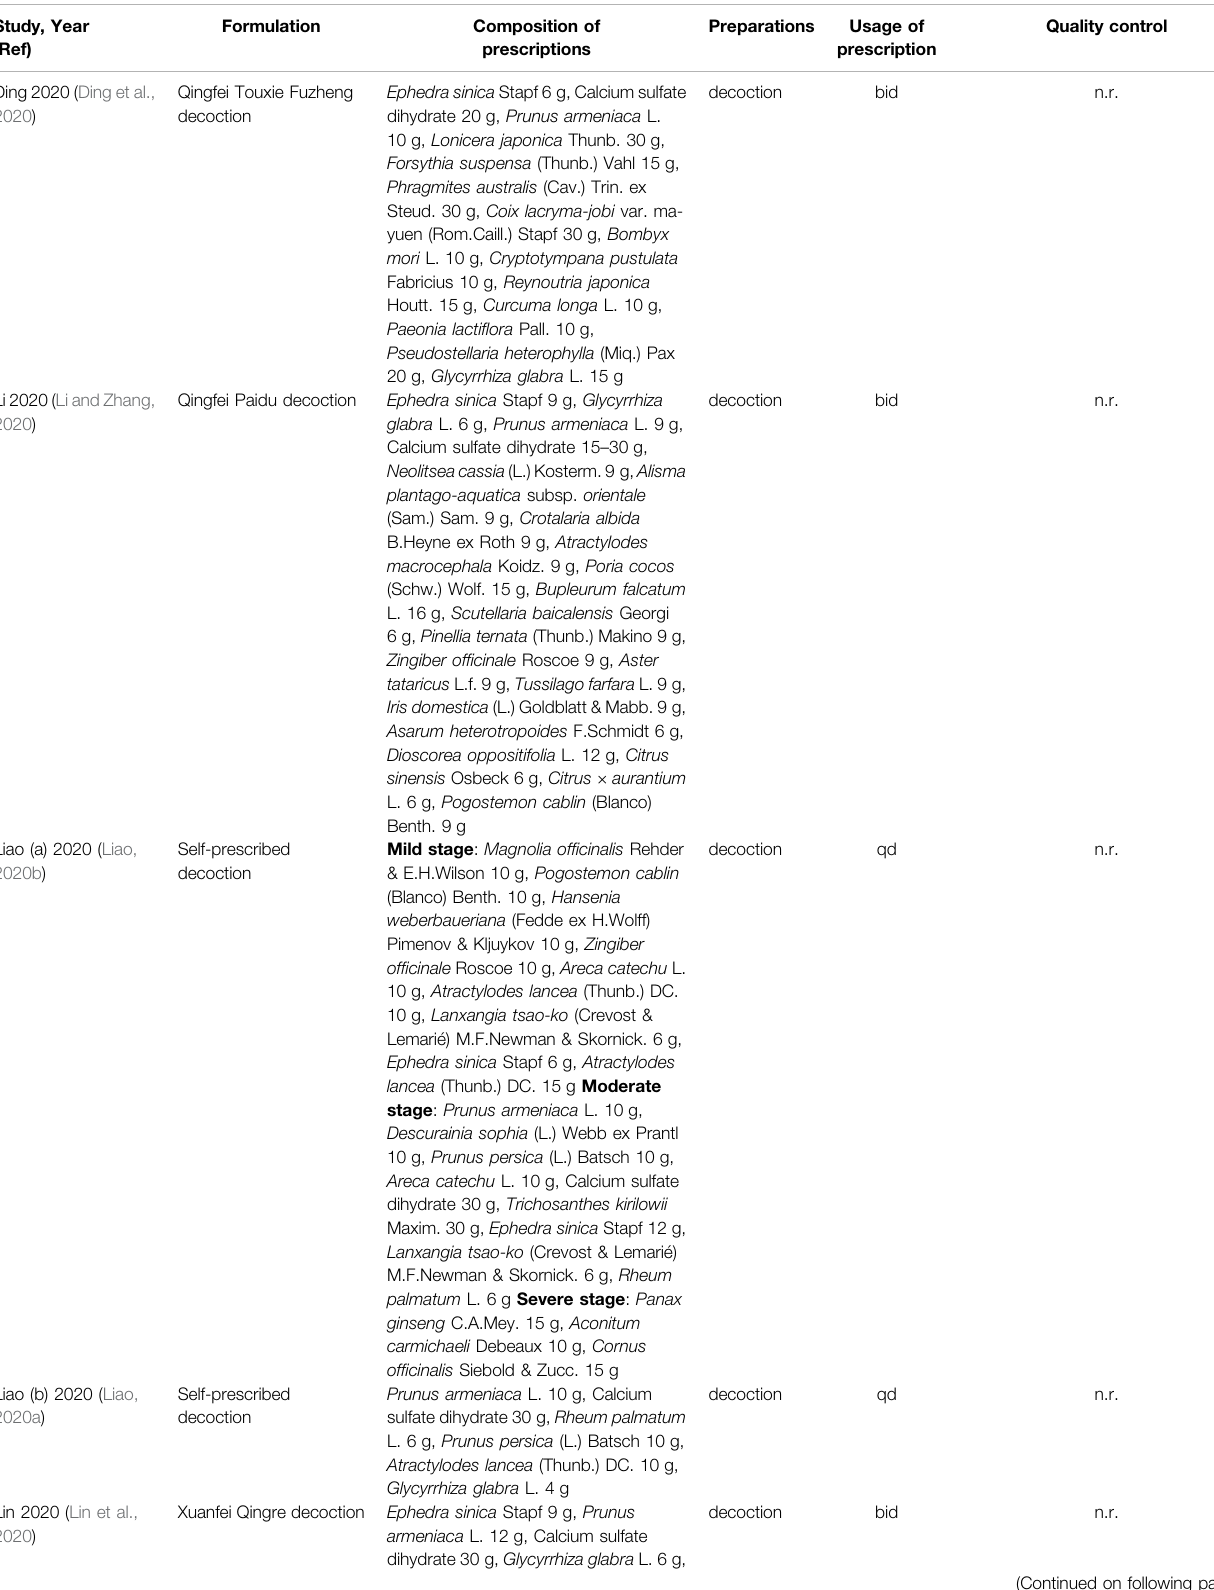
TABLE 2 | Compositions and usage of herbal medicine for the treatment of COVID-19. Study, Year